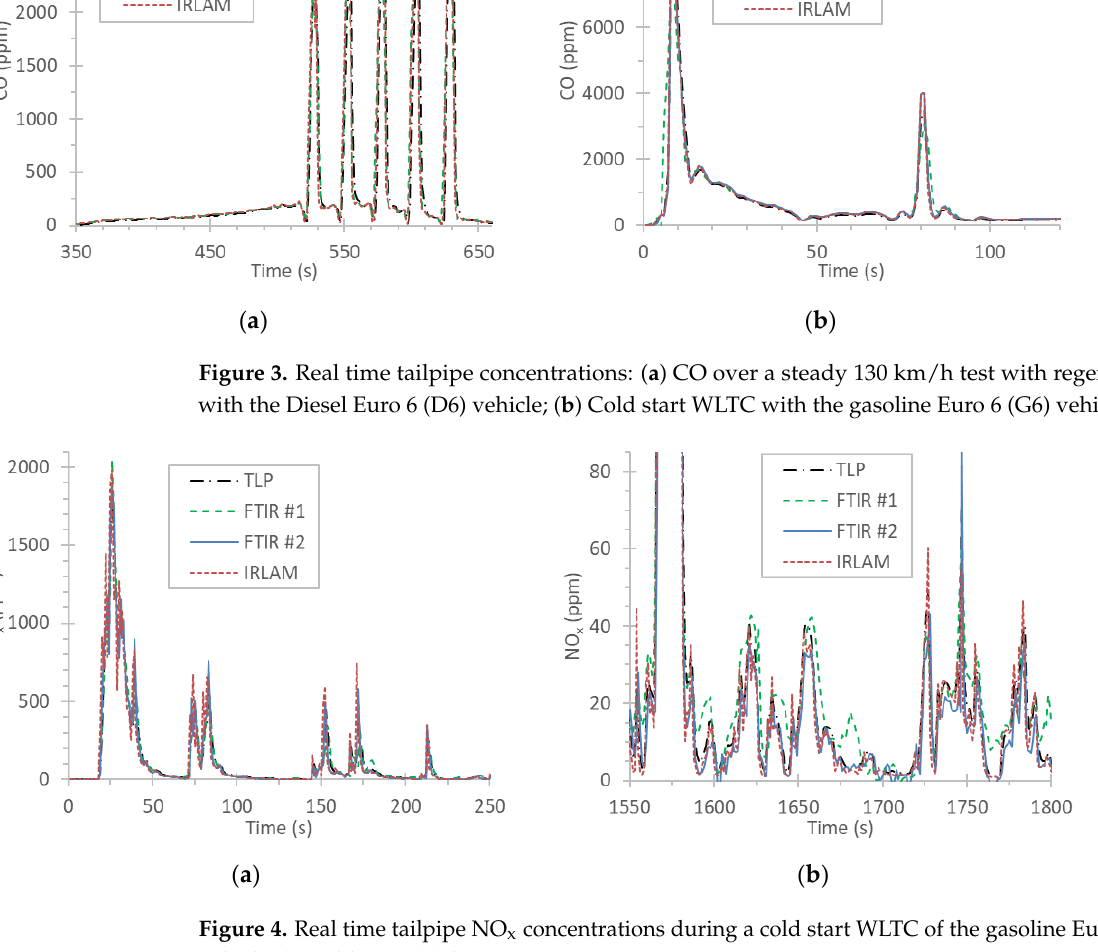
Figure 4. Real time tailpipe NO x concentrations during a cold start WLTC of the gasoline Euro 4 (G4) vehicle: ( a ) cold start; ( b ) last 300 s.